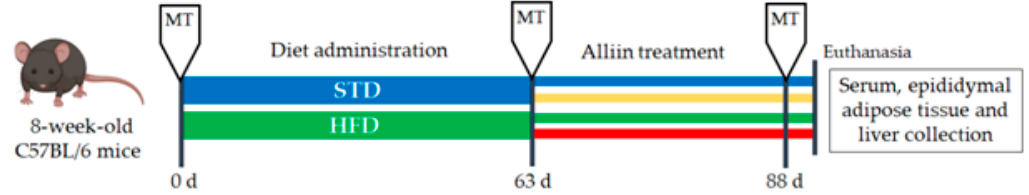
Figure 1. Study design. Metabolic test (MT) that included cholesterol determination, triglycerides test, Oral Glucose Tolerance Test (OGTT), and Intraperitoneal Insulin Tolerance Test (IITT) were performed three times during the study: basal, post-diet treatment, and post-alliin treatment. Once the alliin treatment was finished, euthanasia and tissue collection were performed.